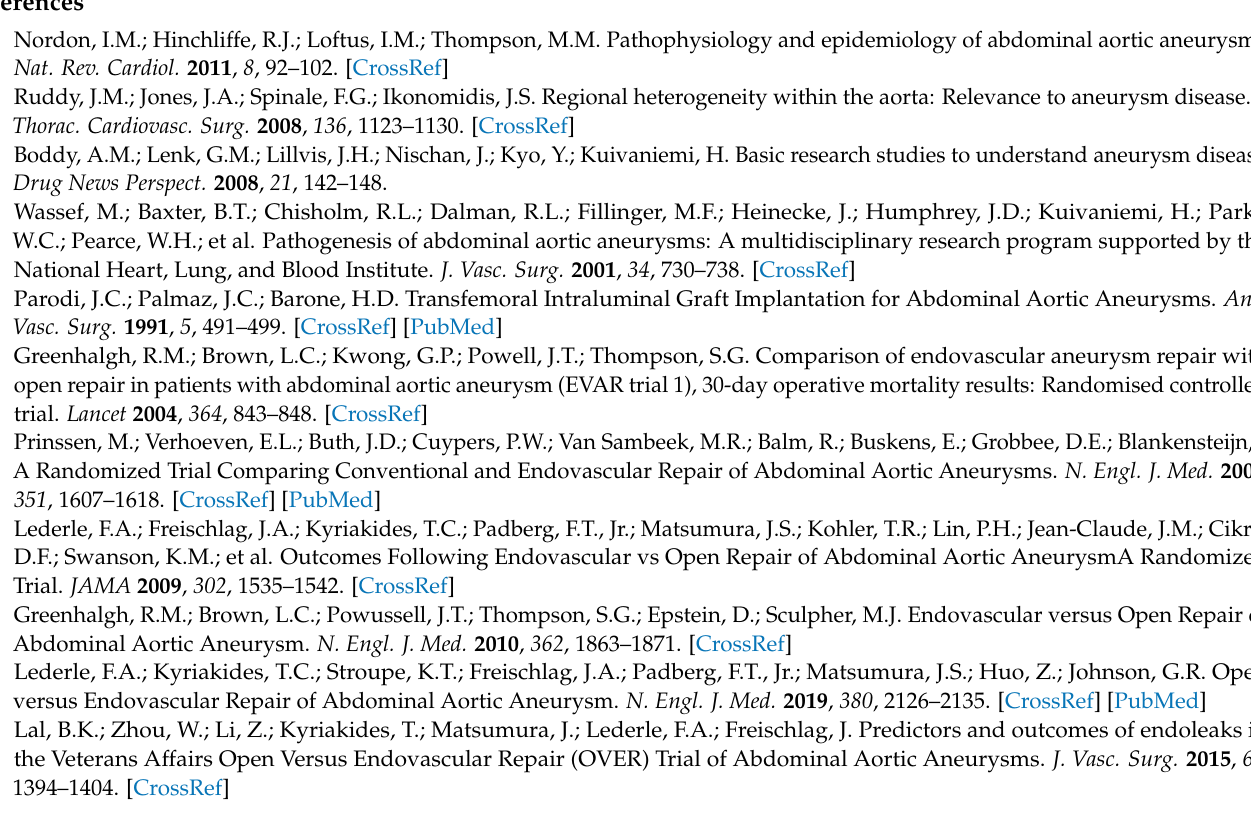
AAA and EVAR specimens. Table S2: Peptides identified by nanoLC-MS/MS. Table S3: Differential intensity distributions of all peptides (MALDI-MSI) and their corresponding proteins from the tunica adventitia in TAA, AAA and EVAR tissue sections. Table S4: Differential intensity distributions of all peptides (MALDI-MSI) and their corresponding proteins from the tunica media in TAA, AAA and EVAR tissue sections. Table S5: Differential intensity distributions of all peptides (MALDI-MSI) and their corresponding proteins from the tunica media in TAA, AAA and EVAR tissue